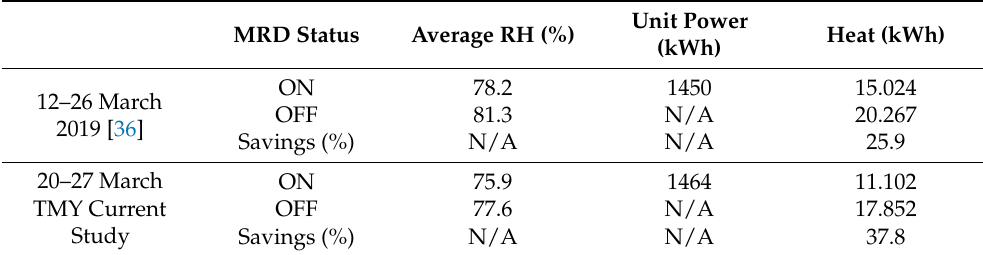
Table 8. Comparison between experimental data and simulation results for MRD spring test case.